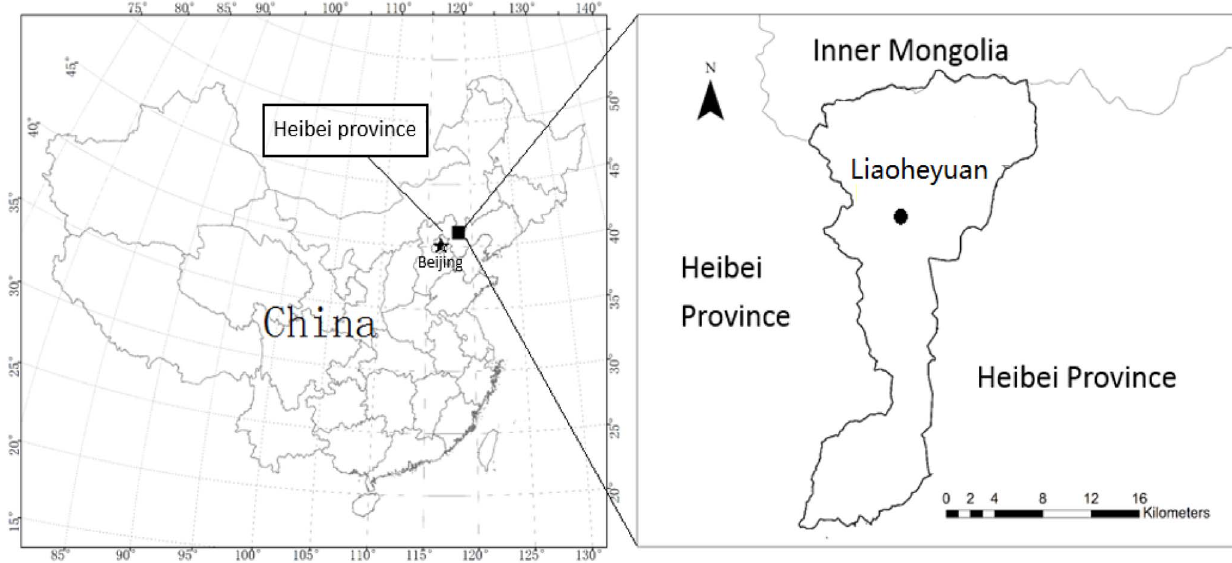
Figure 1. The location of Liaoheyuan, Hebei Province, China.